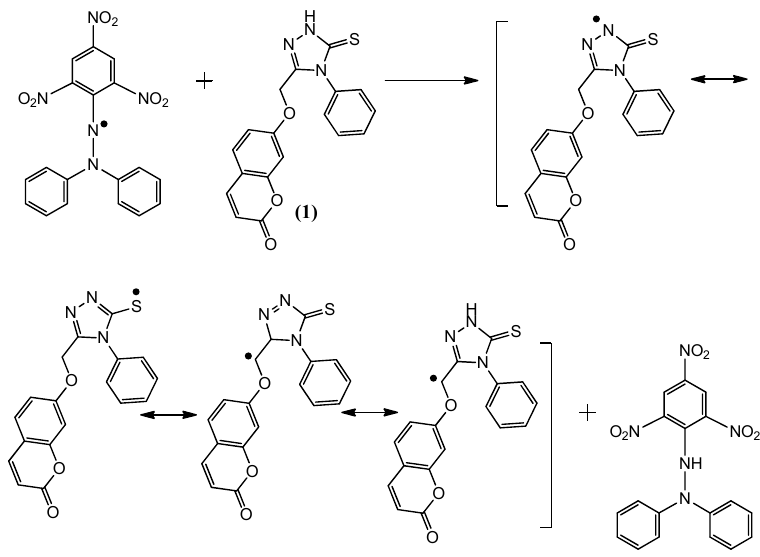
Figure 5. The reaction scheme between DPPH free radicals and compound 3 .